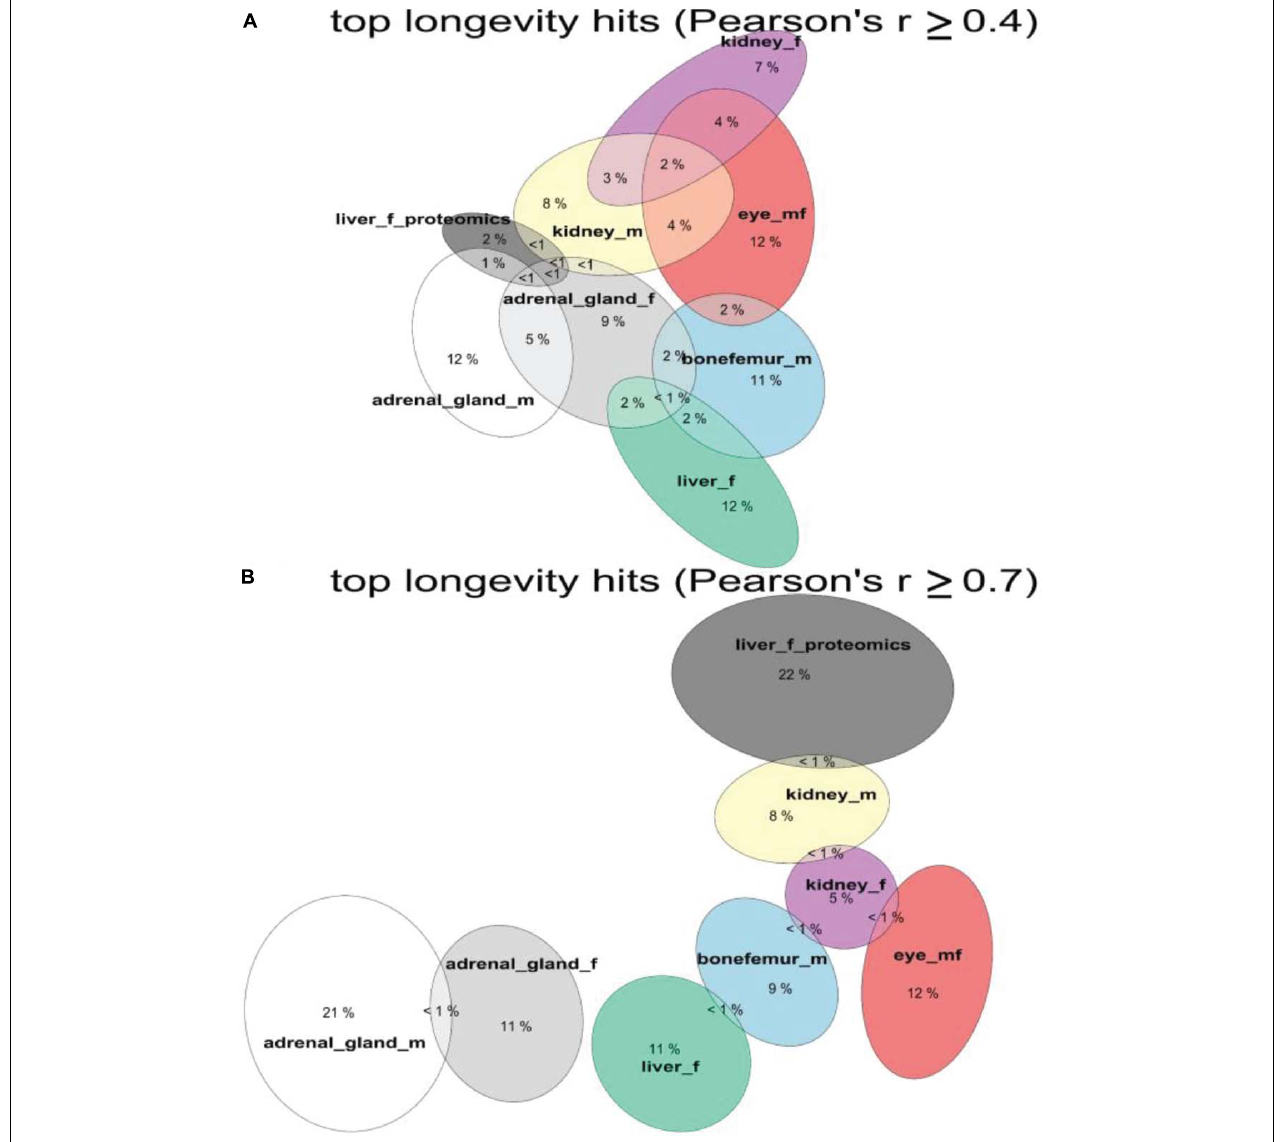
FIGURE 4 | Shared longevity-correlated genes from different tissues. The overlap in percentages of longevity-correlating genes and proteins among tissues and datasets. Overlap with threshold of Person’s | r| > + – = 0.4 for (A) and | r | > + – = 0.7 for (B) . See Supplementary Table 4